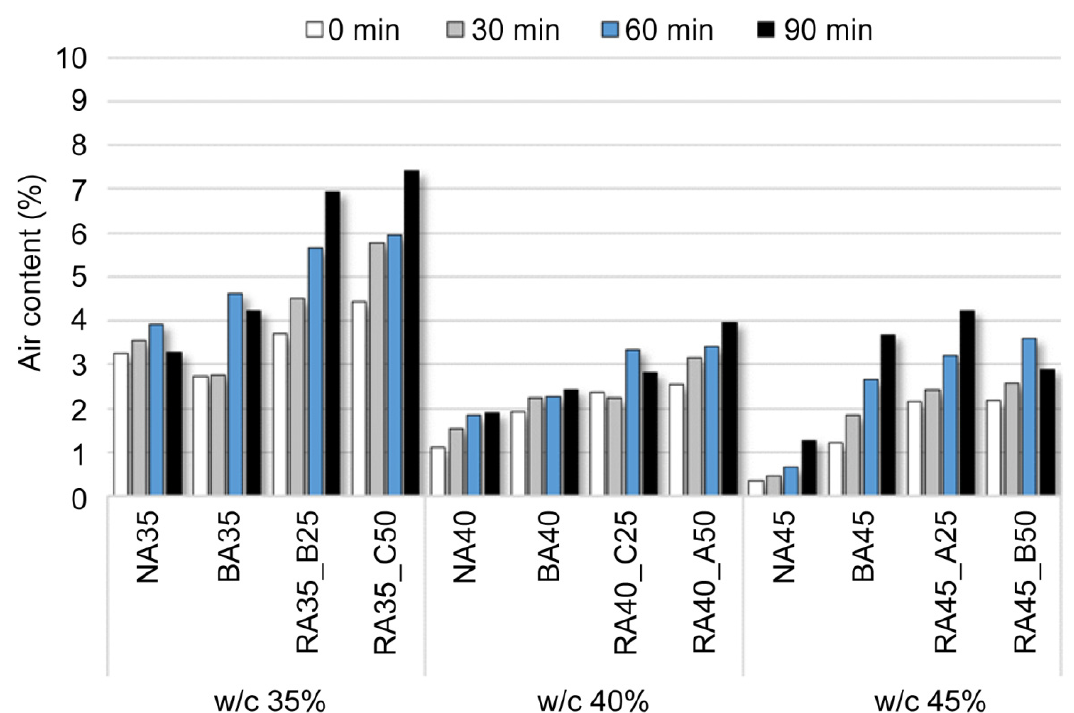
Figure 5. Air content of fresh concrete according to water–cement (w/c) ratio.